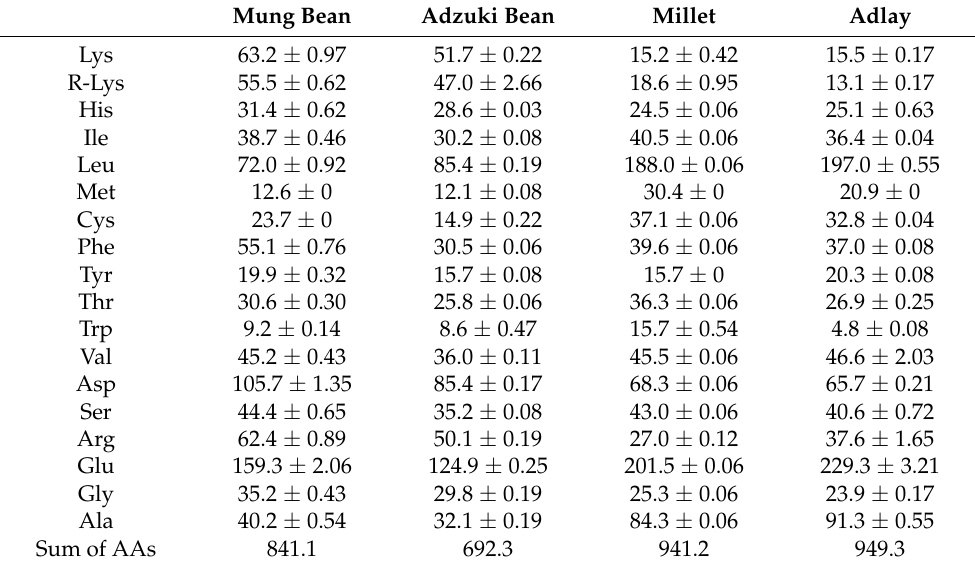
Table 1. Amino acid compositions of the foods (mg/g protein) (mean values ± standard